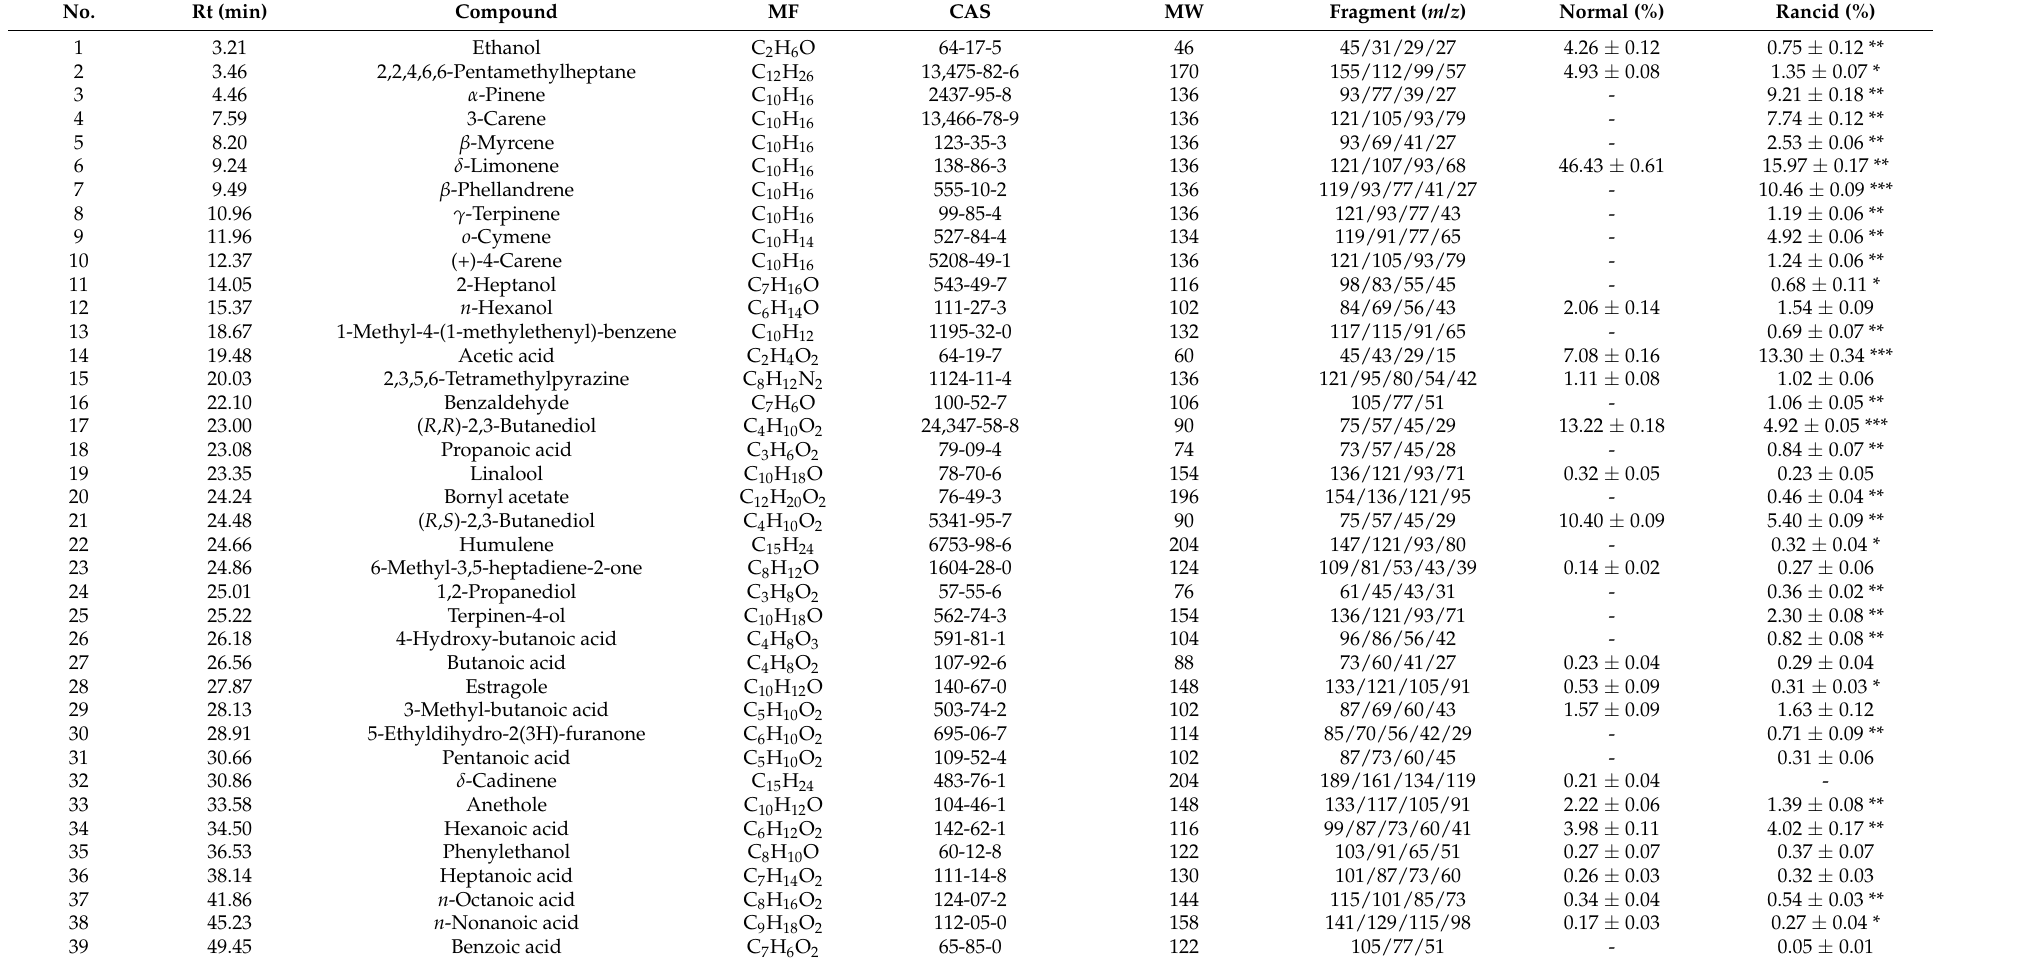
Table 3. Volatile compounds of GC-MS analysis of normal and rancid ZSS